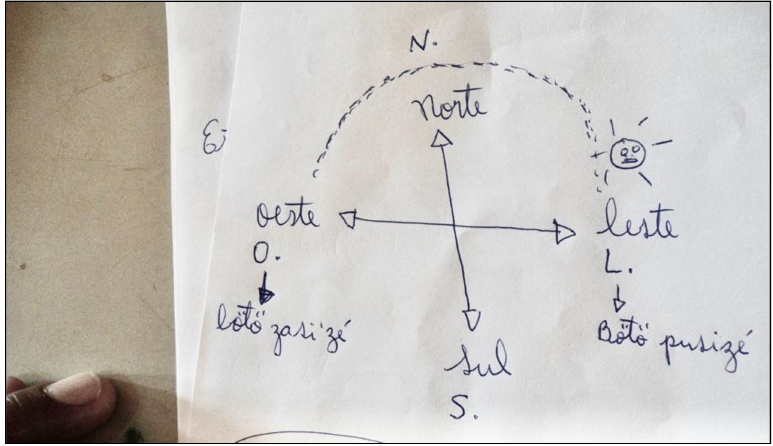
Figure 2. The path of the sun (east-west axis)—Drawing by Valmir Xavante. Source: Field record,